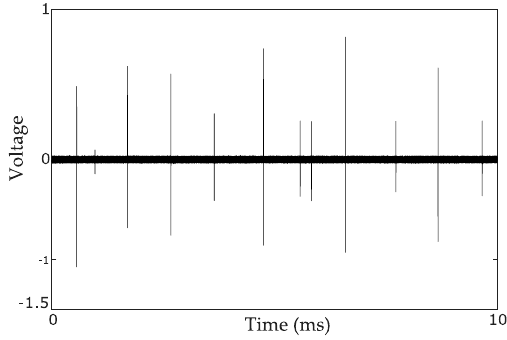
Figure 12. Image representation of a raw PD data recorded in five power cycles.